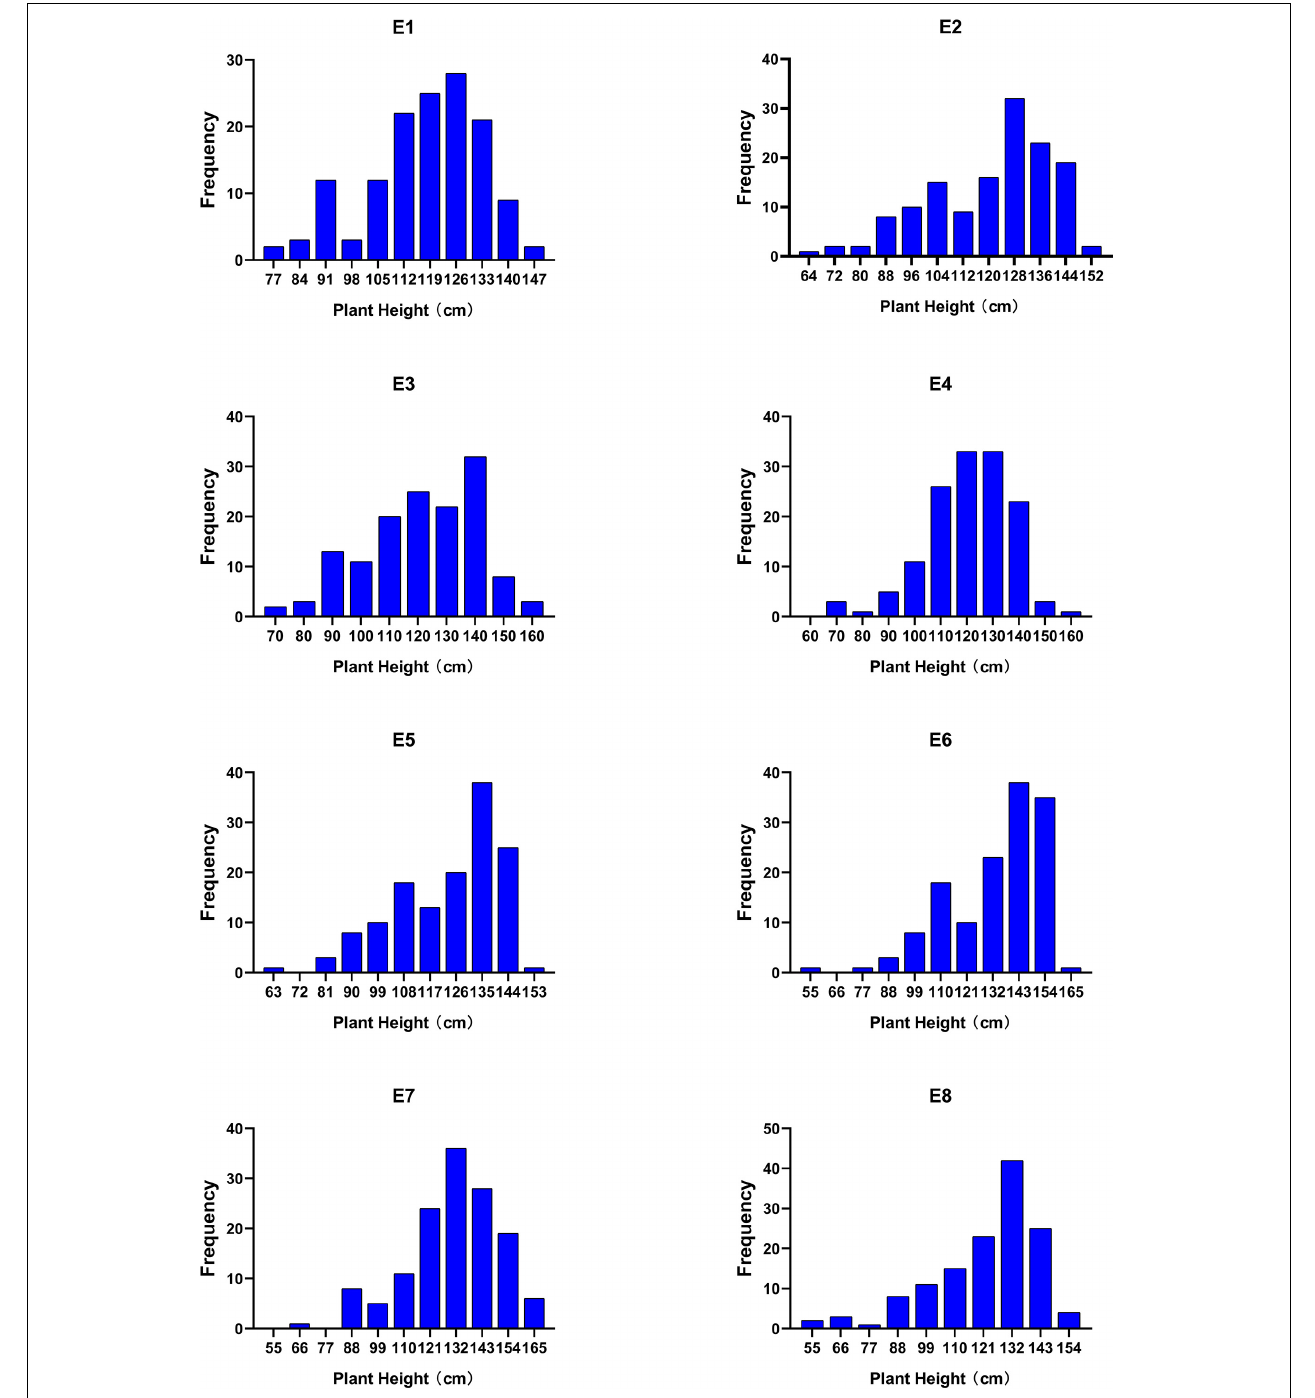
FIGURE 1 | Frequency histograms of plant height in RIL 6013 in eight